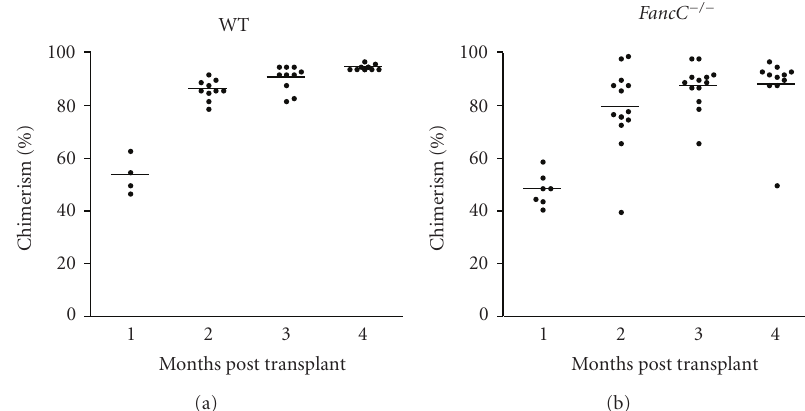
Figure 8: Reconstitution ability of intrafemorally transduced HSC following transplants: percent donor chimerism (CD45.2-positive cells) in peripheral blood cells from recipients transplanted with total BM from preconditioned IF-injected WT and FancC − / − mice as a function of time. Each dot represents donor chimerism of an individual recipient with ten to fourteen mice per genotype. Horizontal line: mean